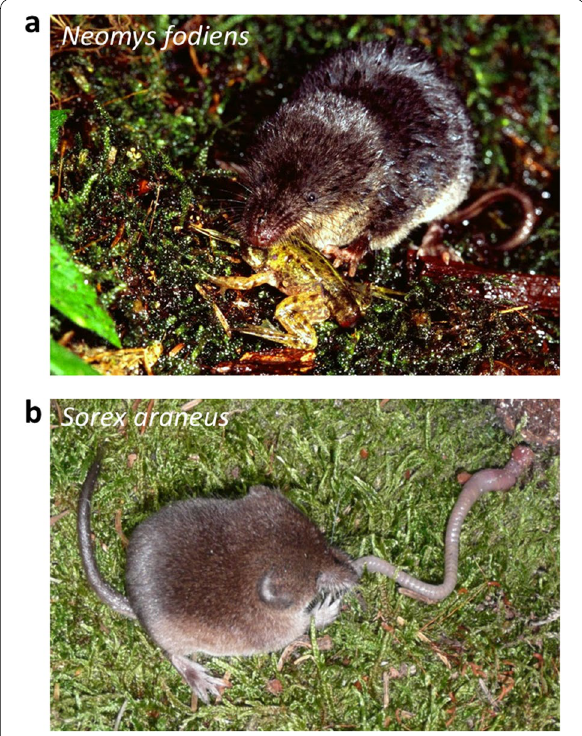
Fig. 1 Venomous shrew species ( a ) The Eurasian water shrew, Neomys fodiens . ( b ) The common shrew, Sorex araneus . Photos: M. Mounier ( a ) and S. von Merten ( b